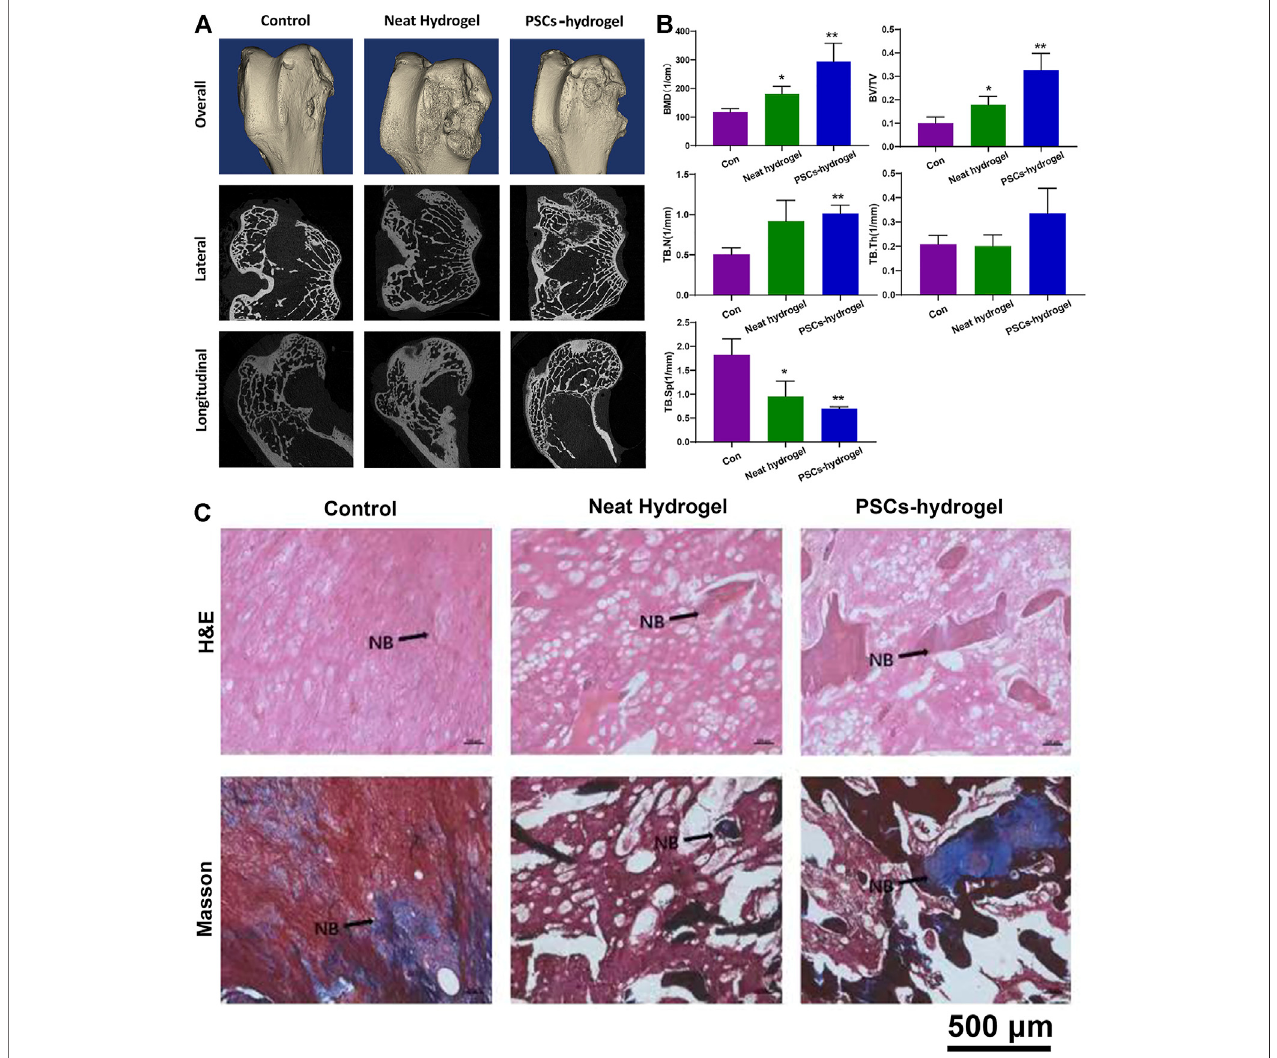
FIGURE6| Invivo boneregenerationassessmentofPCSCs-hydrogels. (A) Reconstructed3Dmicro-CTandsectionalimagesoffemoralcondyleaftertreatedwith PCSCs-hydrogels for 12 weeks. (B) Quantitative evaluation of the regenerated area by analyzing the parameter of micro-CT: BMD, BV/TV, TBN, TB.Sp, and TB.Th. (C) H&E and Masson staining images of bone defect implanted with neat hydrogel and PCSCs-hydrogel. Abbreviation: NB, newly formed bone. Asterisk indicates statistically signi fi cant differences between the control and experience groups ( p p < 0.05 and pp p < 0.01).